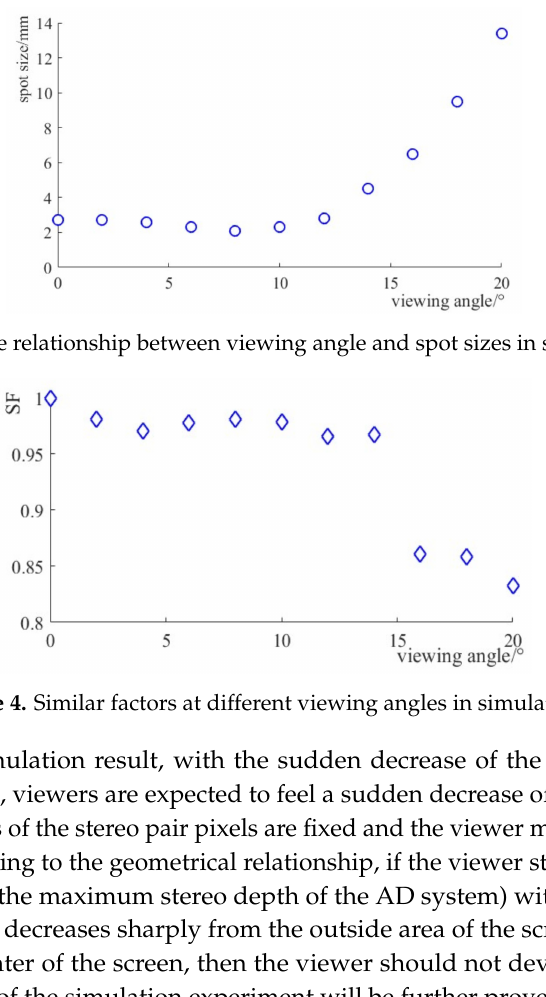
Figure 2. Simulated eye images ( a – f ), of spots and horizontal cross section of spot intensity distributions at viewing angles of 0 ◦ , 4 ◦ , 8 ◦ , 12 ◦ , 16 ◦ , and 20 ◦ .